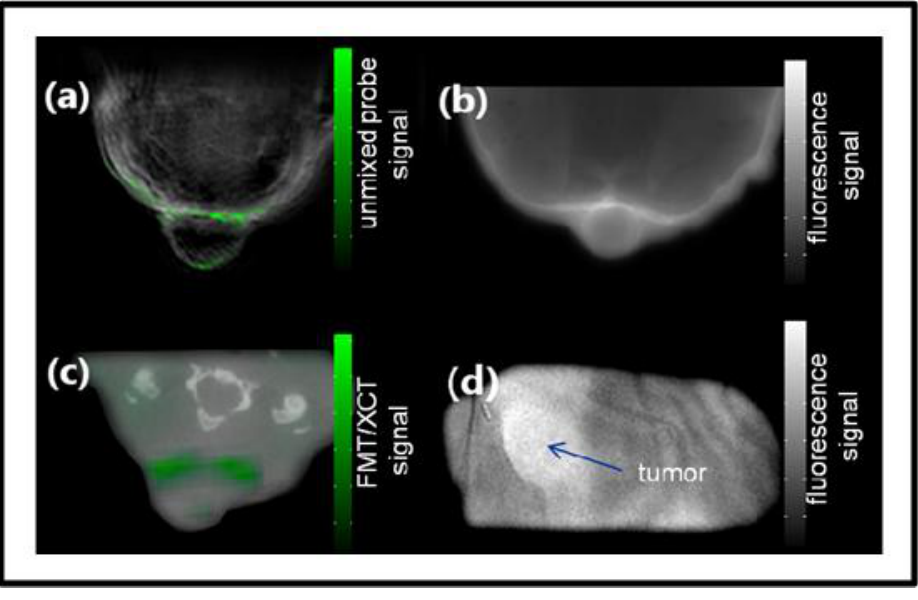
Figure 13. Comparison between optical imaging and MSOT for imaging of a targeted apoptotic marker (PSS-794) in 4T1 tumor-bearing mice by Buehler et al. [161]. ( a ) High resolution MSOT image shows the superposition of a single-wavelength (anatomical) optoacoustic image (in gray scale) and the unmixed component corresponding to the PSS-794 signal (in color); ( b ) Corresponding epi-fluorescent image; ( c ) Reconstruction from a hybrid FMT/XCT modality; ( d ) Planar trans-illumination image. Reprinted with